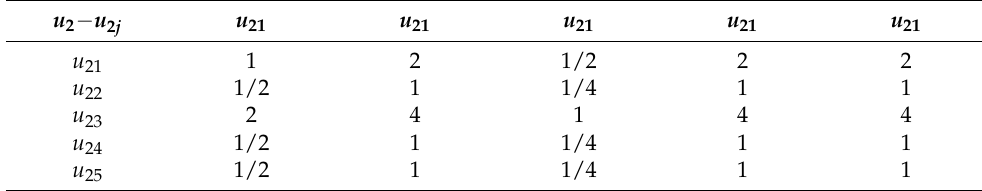
Table 4. Judgment matrix of u 2 − u 2 j